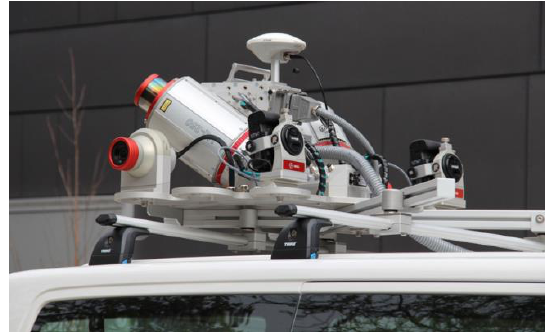
Figure 2: RIEGL VMX-250, mounted on a van